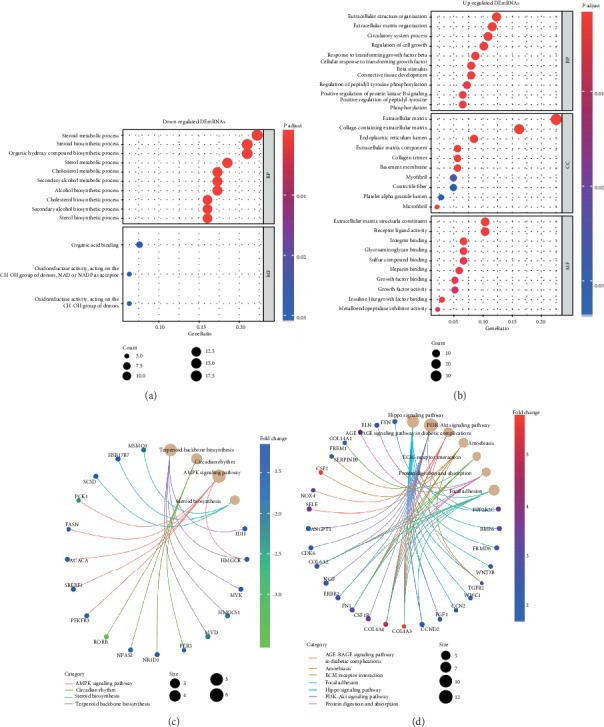
GO and KEGG analyses for significant DEmRNAs in GSE104674. The bubble charts present GO analysis results of downregulated (a) and upregulated mRNAs (b). The network charts present KEGG analysis results of downregulated (c) and upregulated mRNAs (d).